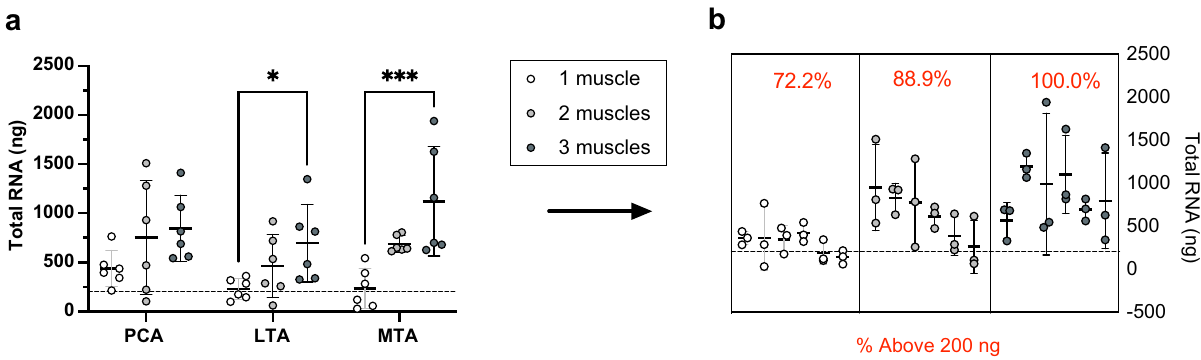
Figure 6. Validation of the pooling strategy . Total RNA was calculated from the volume of the RNA elution buffer (38 µL), and the RNA concentration (ng/µL) was measured via a Nanodrop Spectrophotometer at 260 nm. The black dashed lines denote the target yield of RNA for the different pooling strategies evaluated (200 ng). ( a ) Comparison of total RNA recovery from 1 pooled muscle (PCA, N = 6; LTA, N = 6; MTA, N = 6), 2 pooled muscles (PCA, N = 6; LTA, N = 6; MTA, N = 6), and 3 pooled muscles (PCA, N = 6; LTA, N = 6; MTA, N = 6). ( b ) Nested perspective showing the percentage of extracts greater than 200 ng (red). Analysis of variance was performed using a two-way ANOVA with Posthoc tests. The data is expressed as mean ± SD. * means P < 0.05; ** P < 0.01; *** P < 0.001; **** P < 0.0001. Muscle N 260/230 260/280 Total RNA (ng) RIN 28S/18S No. reads